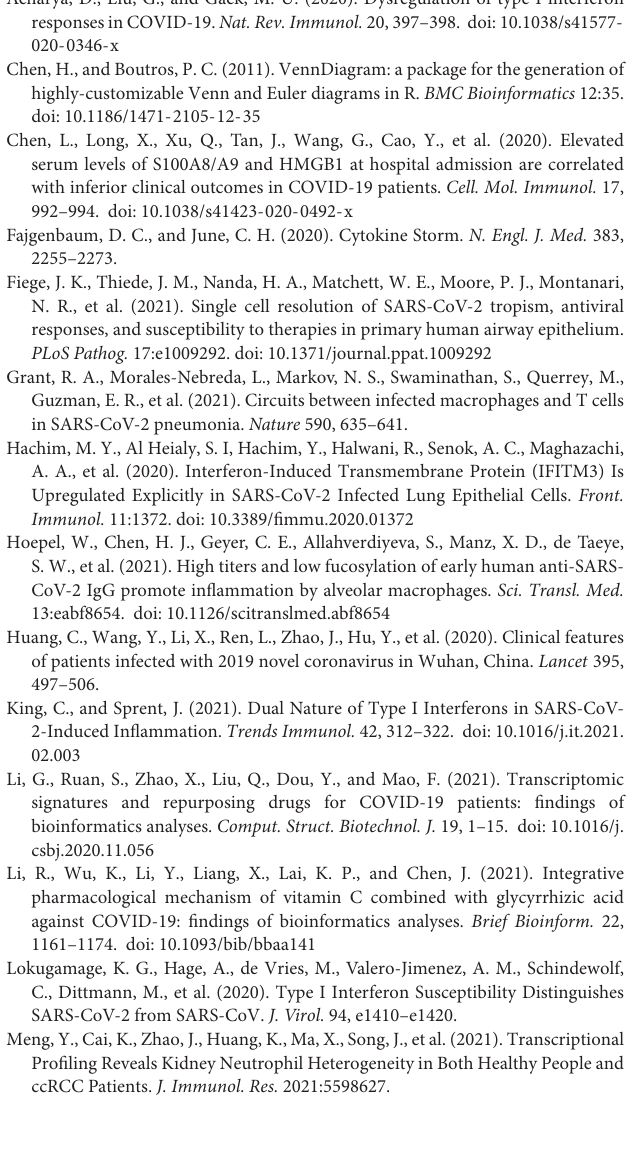
SARS-CoV-2 CD8 + T cells. (F) A heat map revealing the relationship between COVID-19–related genes and DEGs in heavily loaded SARS-CoV-2 neutrophils. demonstrating the COVID-19–related infection-correlated hub gene signatures in the SARS-CoV-2–infected epithelial cells. The molecular complex detection (MCODE) system was used to highlight the main network-connected genes. Supplementary Figure 5 | Shared DEGs in the non-infected cells compared with bacterial pneumonia and control cells. (A) A volcano plot demonstrating the fold change and the significance of the DEGs in epithelial cells from severe and mild ARDS BALF samples. (B) The shared gene signatures between SARS-CoV-2 infection-correlated genes and the severe ARDS-related genes. The PPI network demonstrates the shared gene signatures between SARS-CoV-2 infection-correlated genes and the severe ARDS-related genes. The oval shaped structures indicate the upregulated genes, and the rectangles indicate the